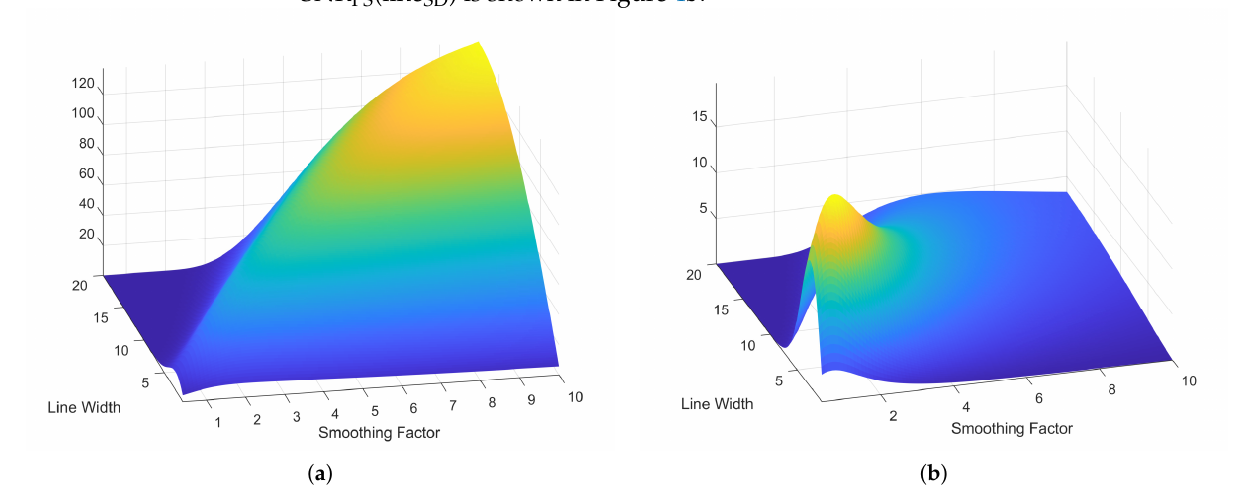
Figure 4. SNR C and SNR PS of the SD-based line detection. ( a ) SNR C (line SD ); ( b ) SNR PS (line SD